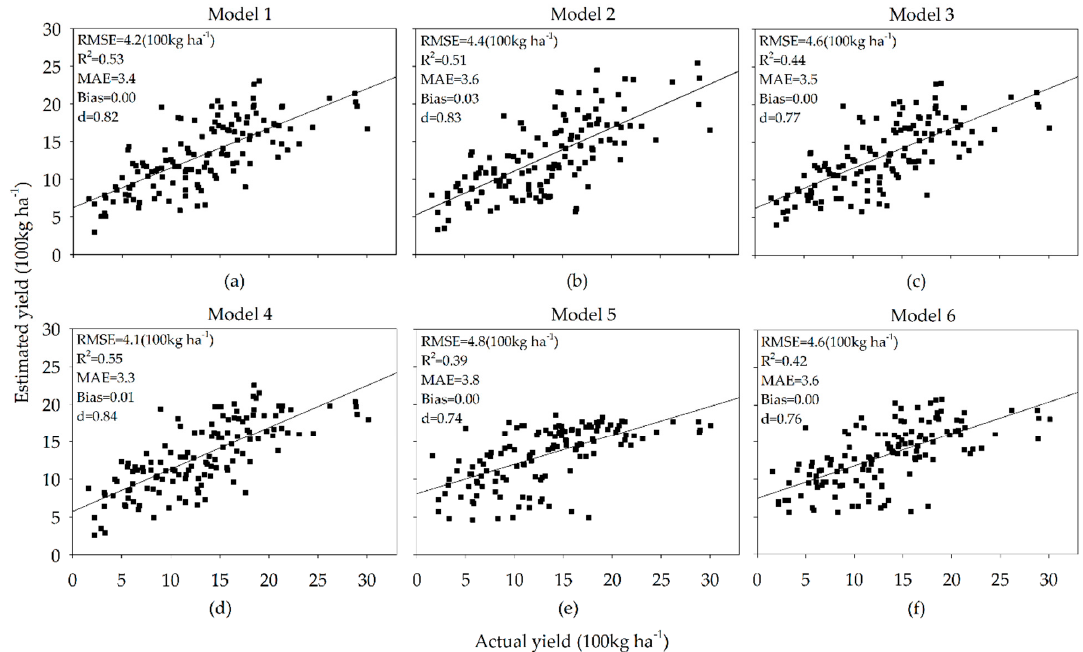
Figure 8. Comparison between actual spring wheat yield with estimated spring wheat yield for each model; model 1 ( a ), model 2 ( b ), model 3 ( c ), model 4 ( d ), model 5 ( e ), model 6 ( f ). Each point indicates the estimated yield versus the actual yield for a single station and